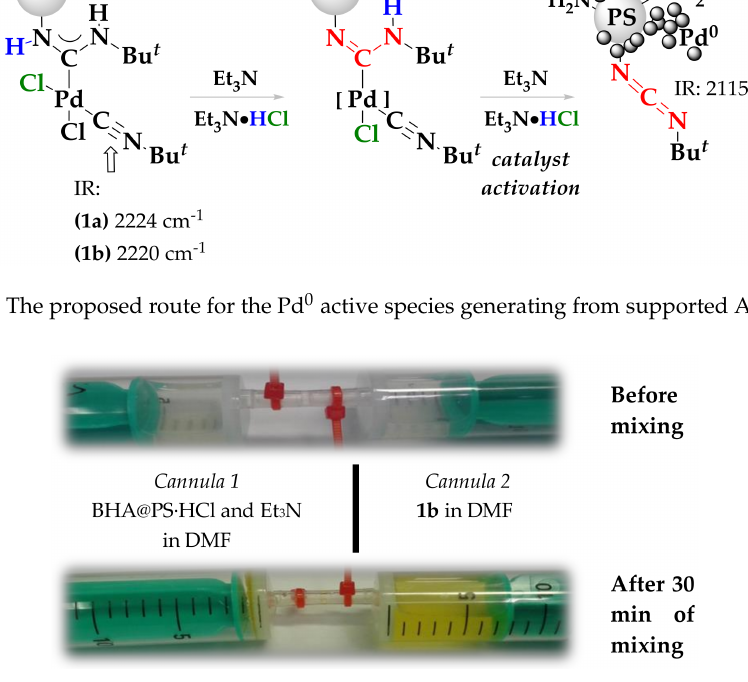
Figure 5. Experiment of a leached palladium binding with benzhydrylamine resin surface.